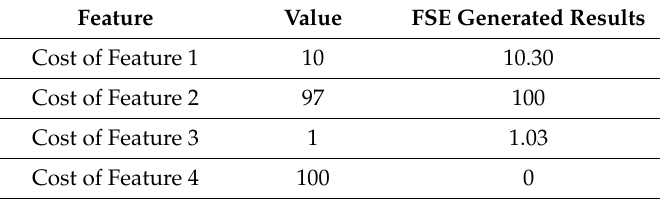
Table 6. Example of values returned by Feature Selection Engine (FSE) for “Upto (Higher